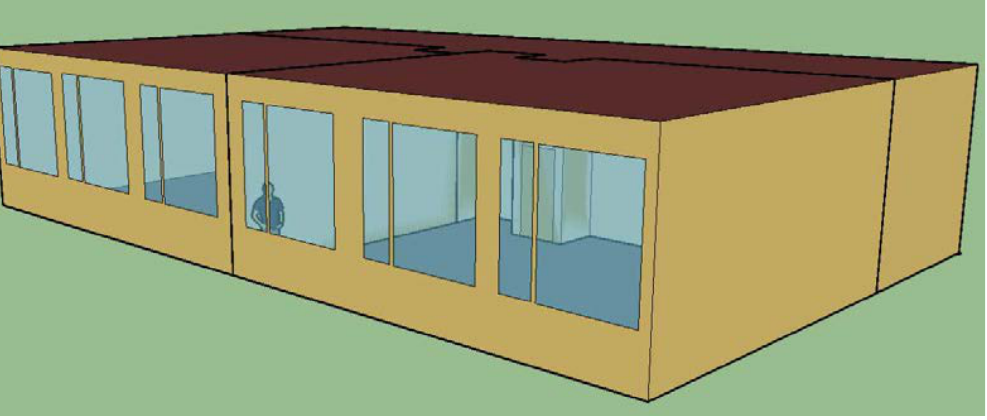
Figure 6. Model geometry of the analysed classroom (right room) generated in SketchUp. Window façade oriented towards east (78°) [Fraunhofer ISE].